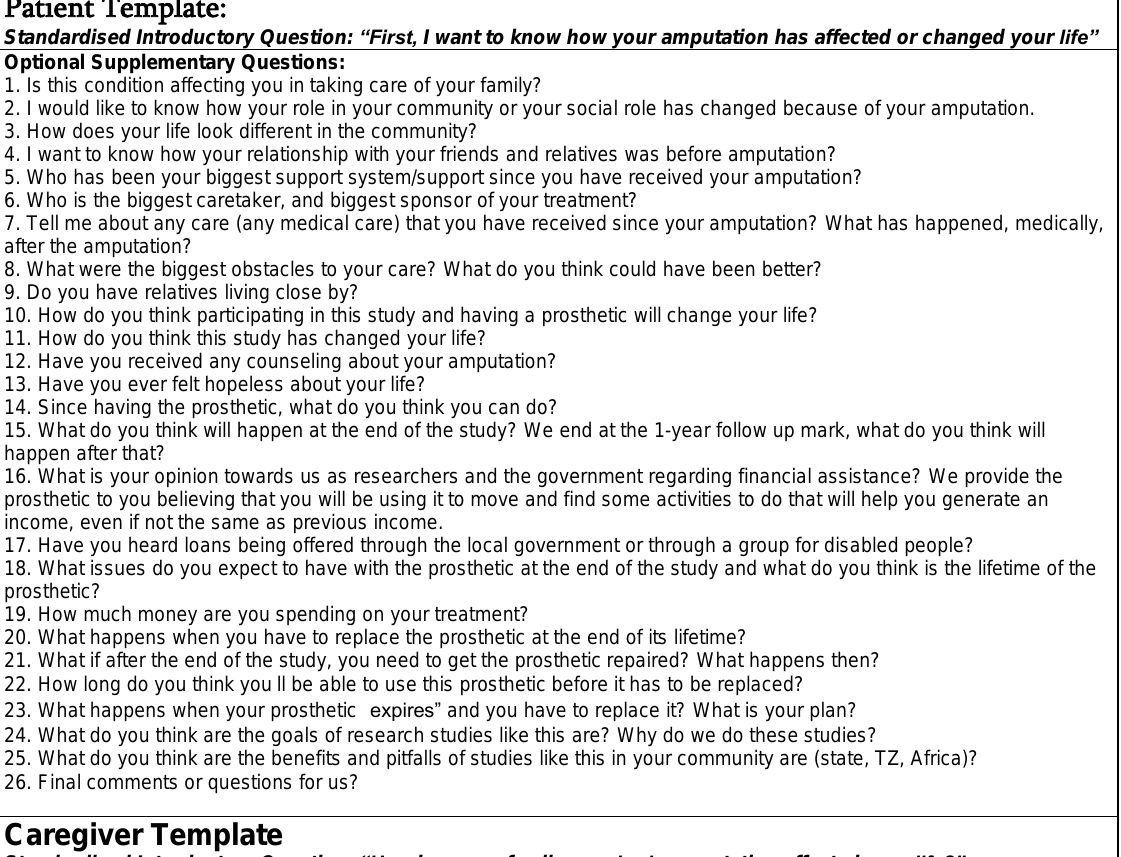
Table 1-A1: List of optional prompts to facilitate discussion, by interviewee role. Patient